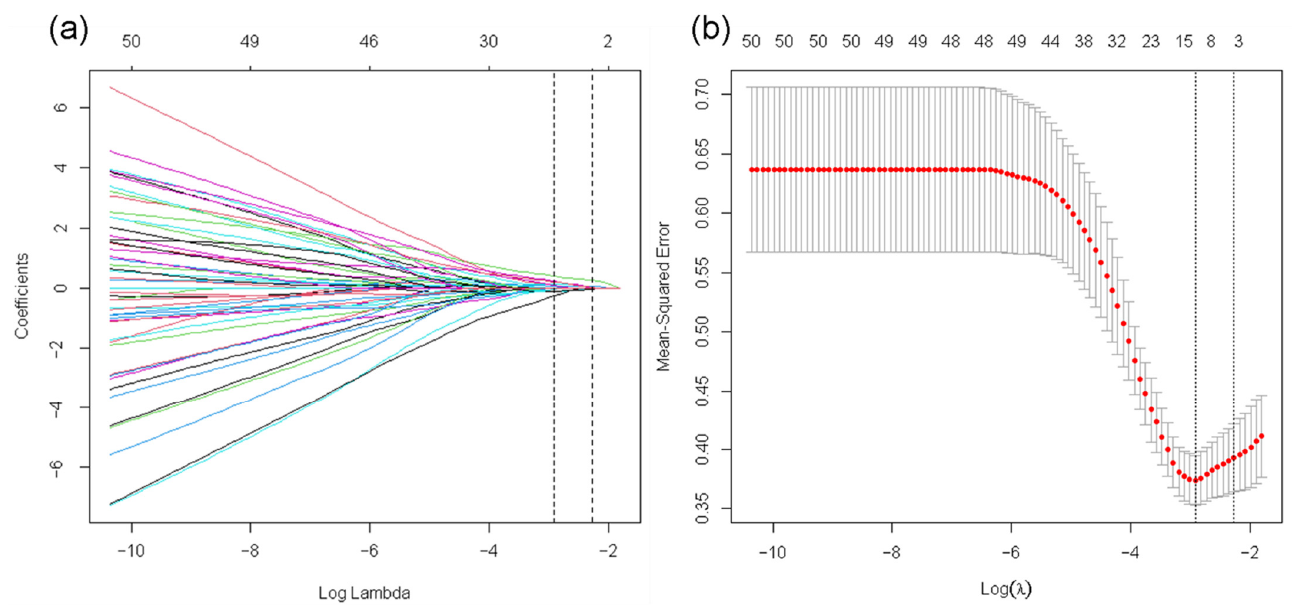
Figure 3. Feature selection for LASSO of the delta-radiomics features. ( a ) Tuning parameter ( λ ) selection by 5-fold cross-validation with minimum criteria. Binomial deviance ( y -axis) was plotted against log( λ ) ( x -axis). The left dotted vertical line was at the optimal lambda value point by using the minimum criteria, and the right line was at the optimal lambda value point by using one standard error of the minimum criteria (the 1-SE criteria). The optimal value of λ was 0.054 (minimum), and the corresponding value of log( λ ) = − 2.919. ( b ) The least absolute shrinkage and selection operator coefficient profiles of the 80 radiomic features after univariate analysis. For the optimal λ , nine features with non-zero coefficients were selected.